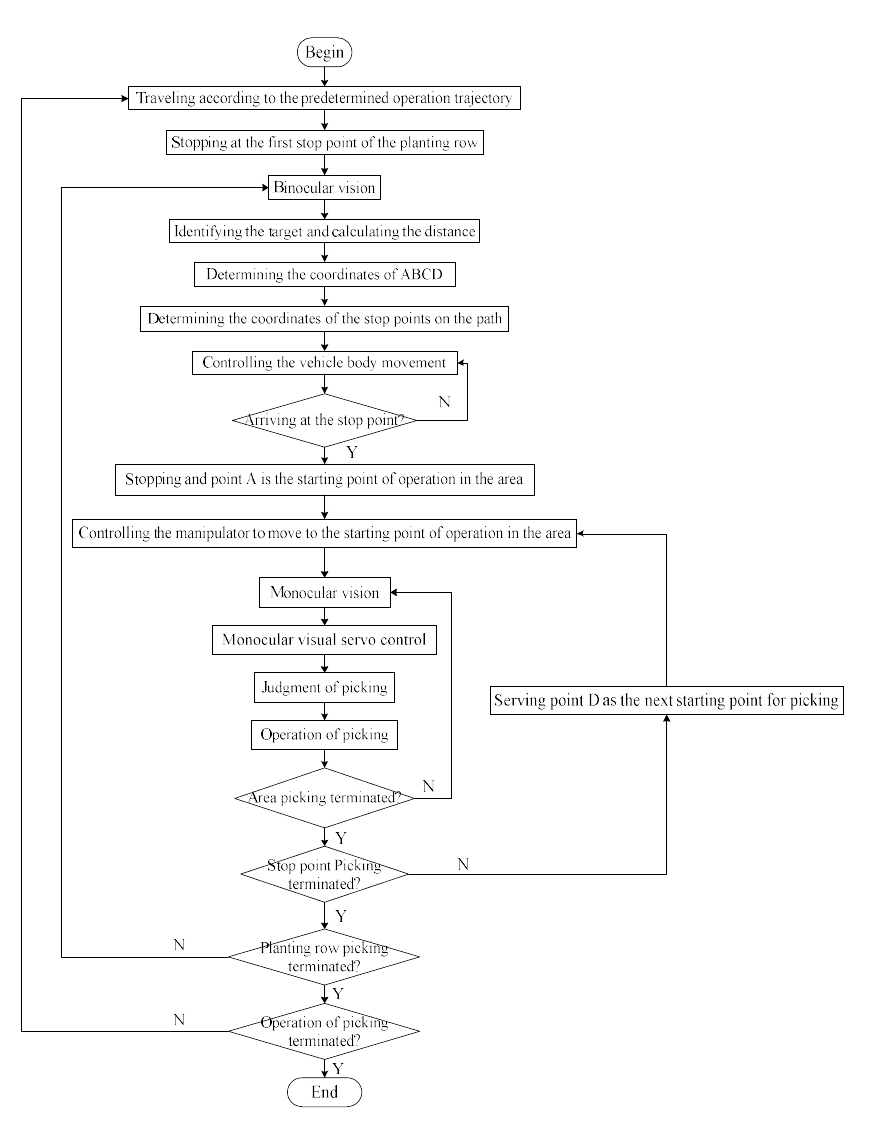
Figure 2. Process of the robot’s visual servo picking operation.